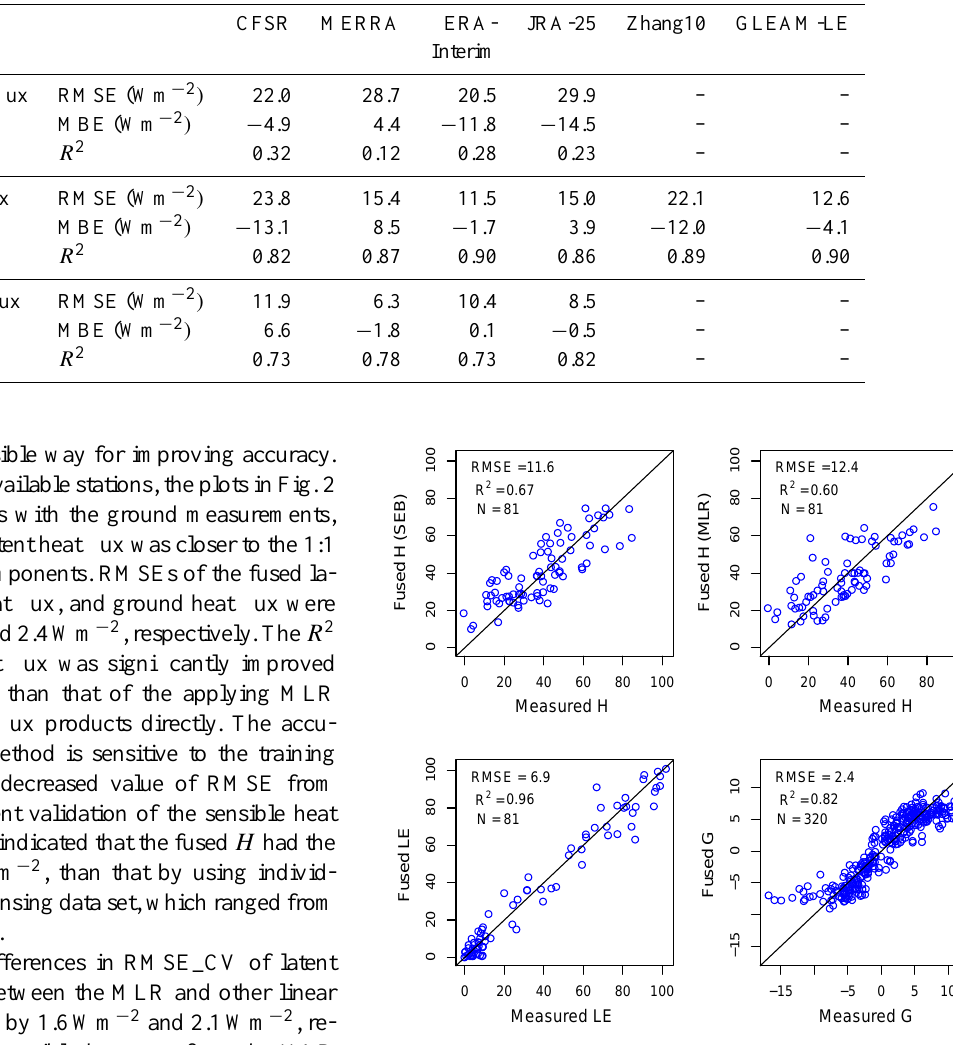
Figure 2. Comparisons of the measured and the predicted (fused) sensible heat flux ( H ), latent heat flux (LE), and ground heat flux ( G ) by Eq. (3) (SEB: estimating the sensible heat flux form the surface energy balance; MLR: applying multiple linear regression method to fuse multiple sensible heat data